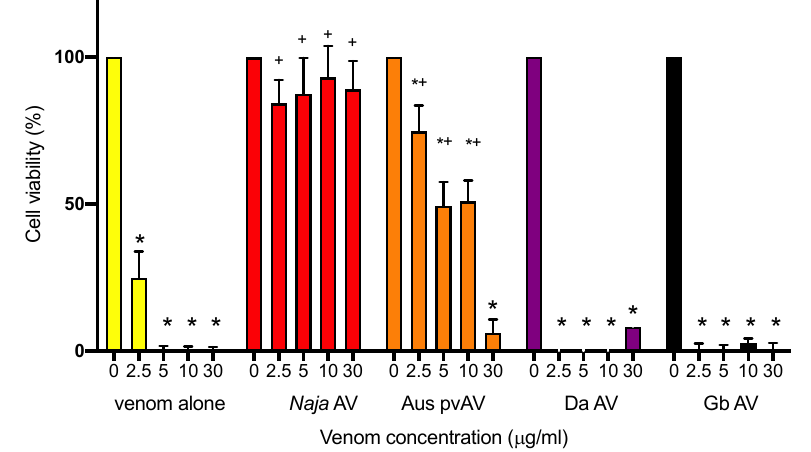
Figure 6. The e ff ects of N. atra venom (0–30 µ g / mL), in L6 cells, in the presence and absence of N. atra Figure 6. The effects of N. atra venom (0–30 µg/mL), in L6 cells, in the presence and absence of N. atra antivenom ( Naja AV, 4 U / mL), G. brevicaudus antivenom AV (Gb AV, 24 U / mL), D. acutus antivenom AV antivenom ( Naja AV, 4 U/mL), G. brevicaudus antivenom AV (Gb AV, 24 U/mL), D. acutus antivenom AV (Da AV, 8 U/mL) or Australian polyvalent AV (Aus pvAV, 33 U/mL). * p < 0.05, significantly (Da AV, 8 U / mL) or Australian polyvalent AV (Aus pvAV, 33 U / mL). * p < 0.05, significantly di ff erent different from control (i.e., 0 venom); + p < 0.05, significantly different from same concentration of from control (i.e., 0 venom); + p < 0.05, significantly di ff erent from same concentration of venom in venom in the absence of antivenom.